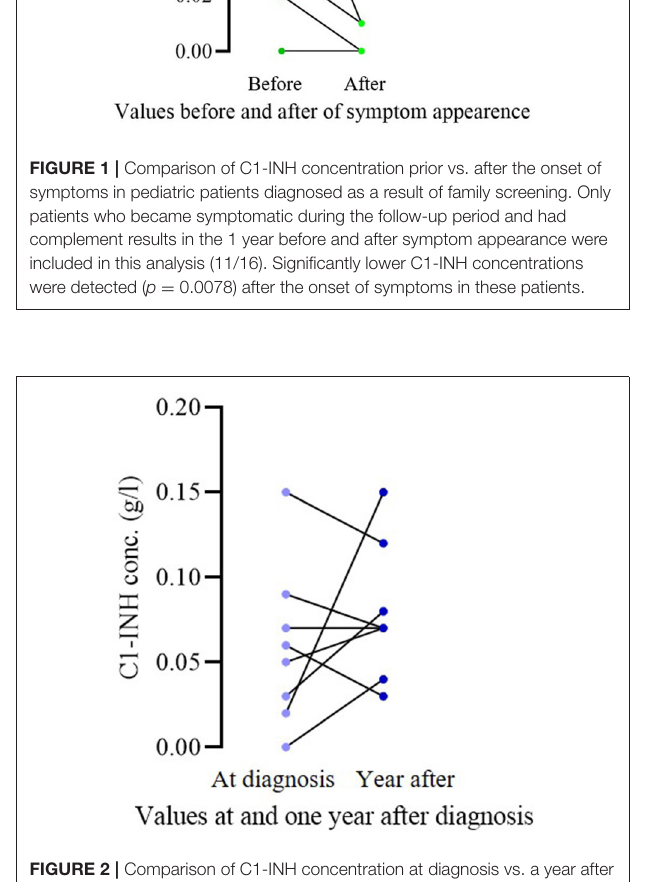
FIGURE 2 | Comparison of C1-INH concentration at diagnosis vs. a year after in asymptomatic pediatric patient. In the case of 8 asymptomatic patients, the C1-INH levels at diagnosis and in the year after were compared. No significant change could be detected ( p =